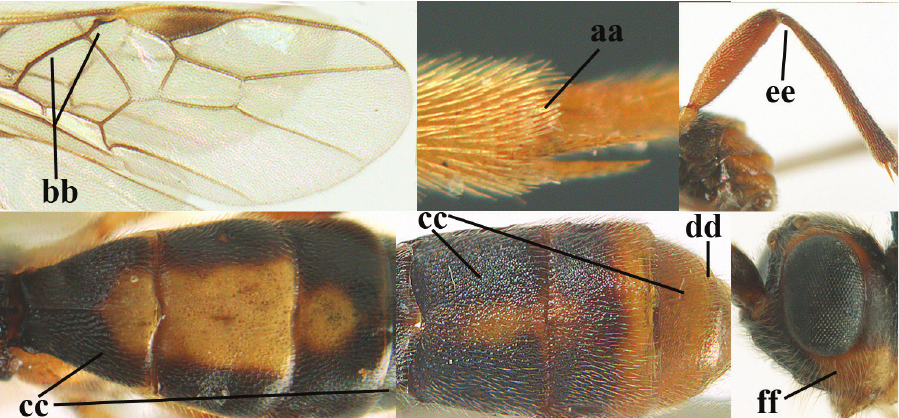
1-M and 1-SR of fore wing subhyaline and similar to surroundings (bb); metasoma less patterned (cc); fourth tergite of ♀ dark brown or yellowish brown latero-posteriorly (dd); base of hind tibia usually yellowish brown (ee); [malar space (ff) and head shape variable]; A. circumscriptus - group ......... 21